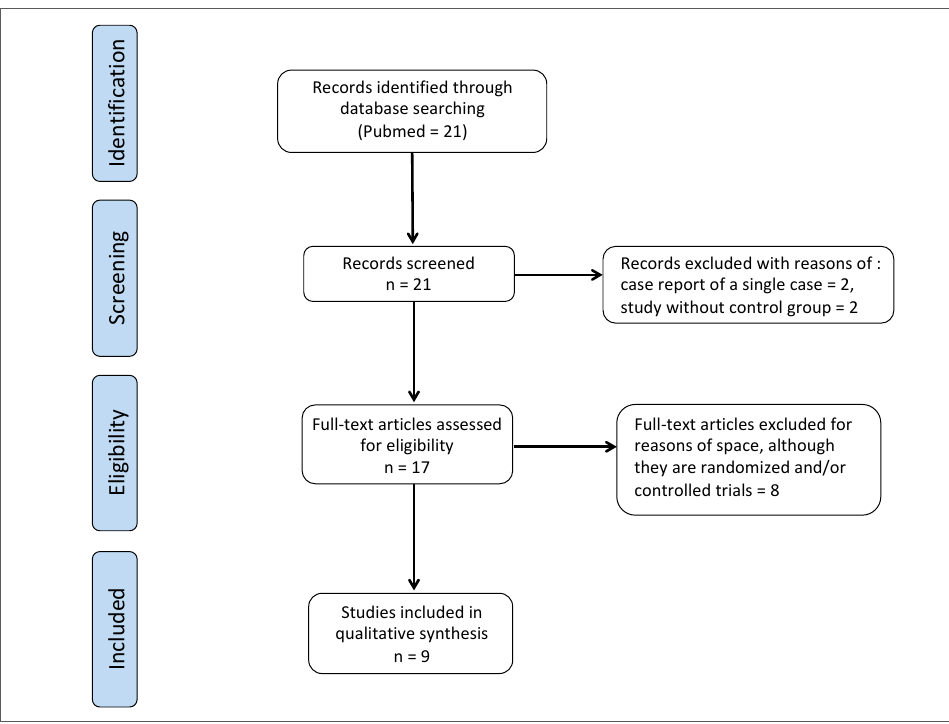
Figure 2. Explanatory flow chart of the narrative revision methodology.